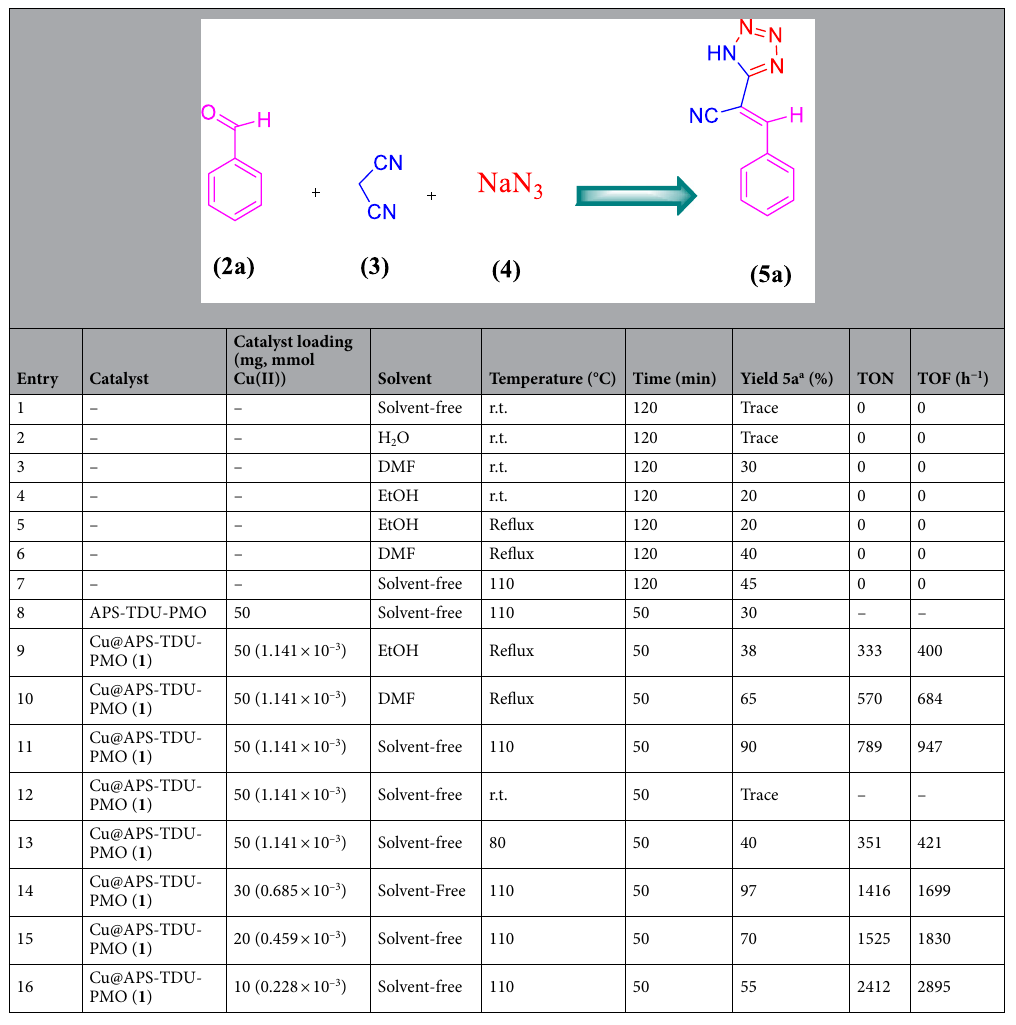
Table 2. Screening of optimal conditions for the synthesis of ( E )-3-phenyl-2-(1 H -tetrazol-5-yl)acrylonitrile product 5a . Reaction conditions: benzaldehyde ( 2a , 1.0 mmol), malononitrile ( 3 , 1.0 mmol), sodium azide ( 4